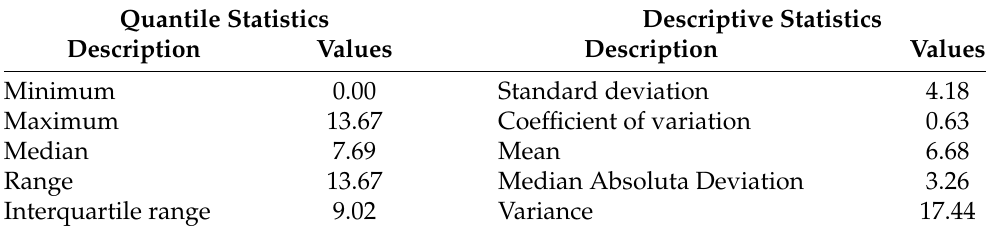
Figure 1. Time series overview of the energy consumption of the focal site (January–November 2020). Table 1. Quantile and descriptive